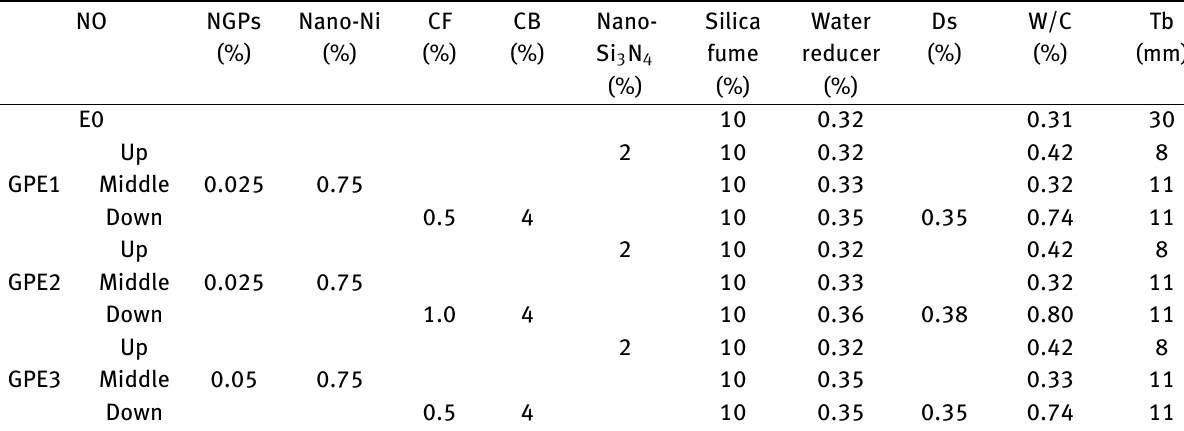
Table 1: Mix proportion and thickness of